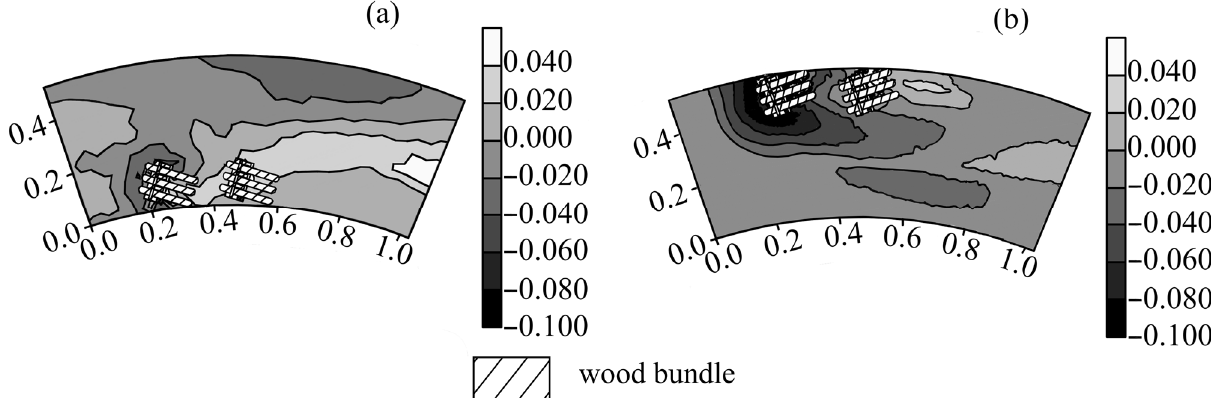
Figure 12. Scour maps for ( a ) test 38, having Type B i , and ( b ) test 49, having Type Bo . All dimensions are in metres and the flow is from left to right.